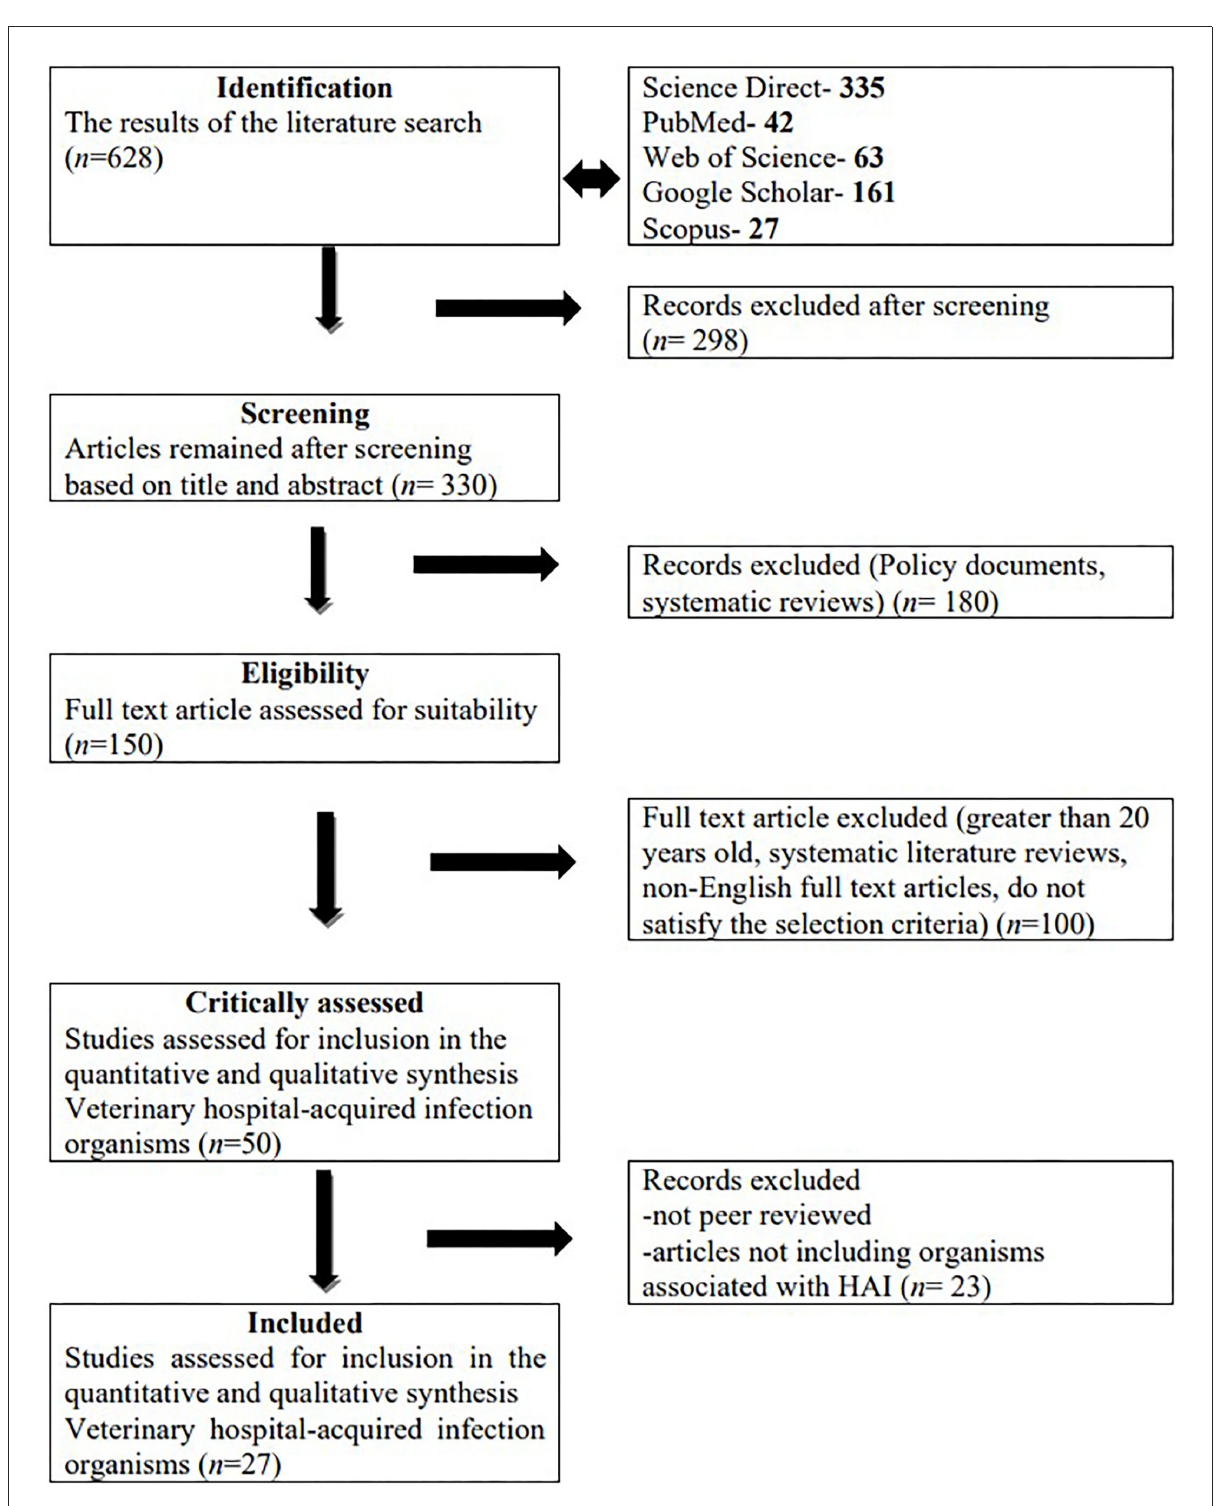
FIGURE1 Summary of study selection and exclusion using the preferred reporting items for systematic reviews and meta-analyses (PRISMA)